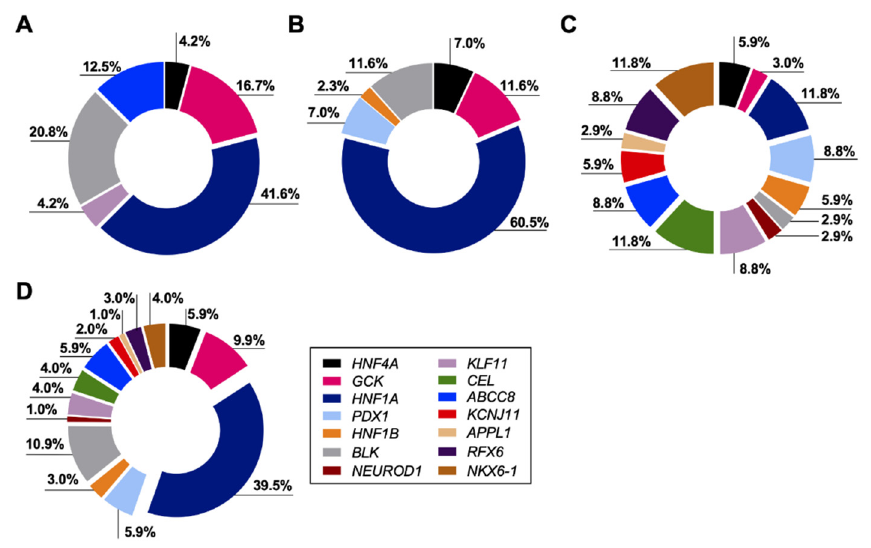
Figure 3. Proportion of subjects carrying MODY-causing mutations. Donut charts represent the proportions of subjects carrying: ( A ) previously reported pathogenic and likely pathogenic MODY-causing mutations ( n = 28 subjects); ( B ) previously reported disease-causing (DM) or likely disease-causing (DM?) variants in the Human Gene Mutation Database, predicted to be among the top 1% most deleterious mutations in the human genome ( n = 43 subjects); ( C ) novel fully penetrant, potentially MODY-causing mutations detected and predicted to be among the top 1% most deleterious mutations in the human genome ( n = 34 subjects). ( D ) Donut chart illustrates the overall proportions of subjects ( n = 101) carrying the previously known and potentially novel MODY-causing mutations. All genes are color coded, while percentages of subjects carrying each mutation subtype are also shown.